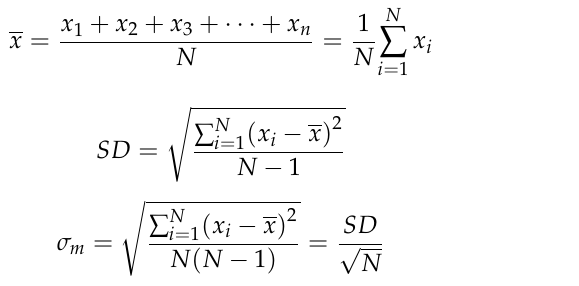
Table 5. Uncertainty of mean analysis of the measured data.